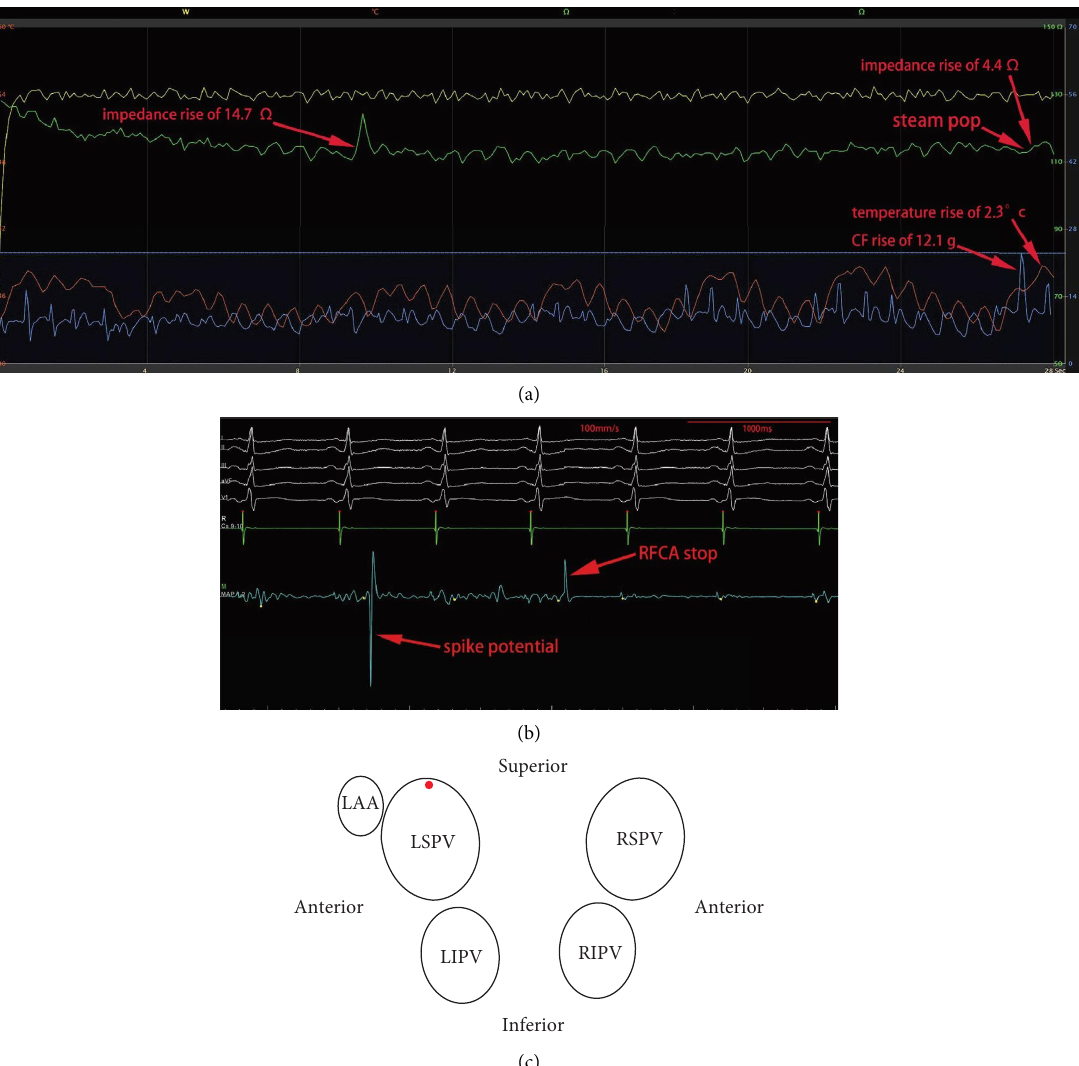
Figure 3: (a) Te time from the initiation of RFCA to the occurrence of audible SP was 27.3s. Te occurrence of SP was associated with a preceding impedance drop of 18.5 Ω . Te sudden impedance rise after 27.3s of RFCA coincided with a SP. Immediately after the SP, an abrupt impedance rise of 4.4 Ω , temperature rise of 2.3 ° C, and CF rise of 12.1g were recorded. (b) A spike potential without consequent PAC was recorded immediately during the occurrence of SP. Of note, this RFCA application had 1 previous signifcant impedance rise of 14.7 Ω at 9.4s but without concomitant temperature and CF change. (c) Te location of the SP is at the roof wall of the